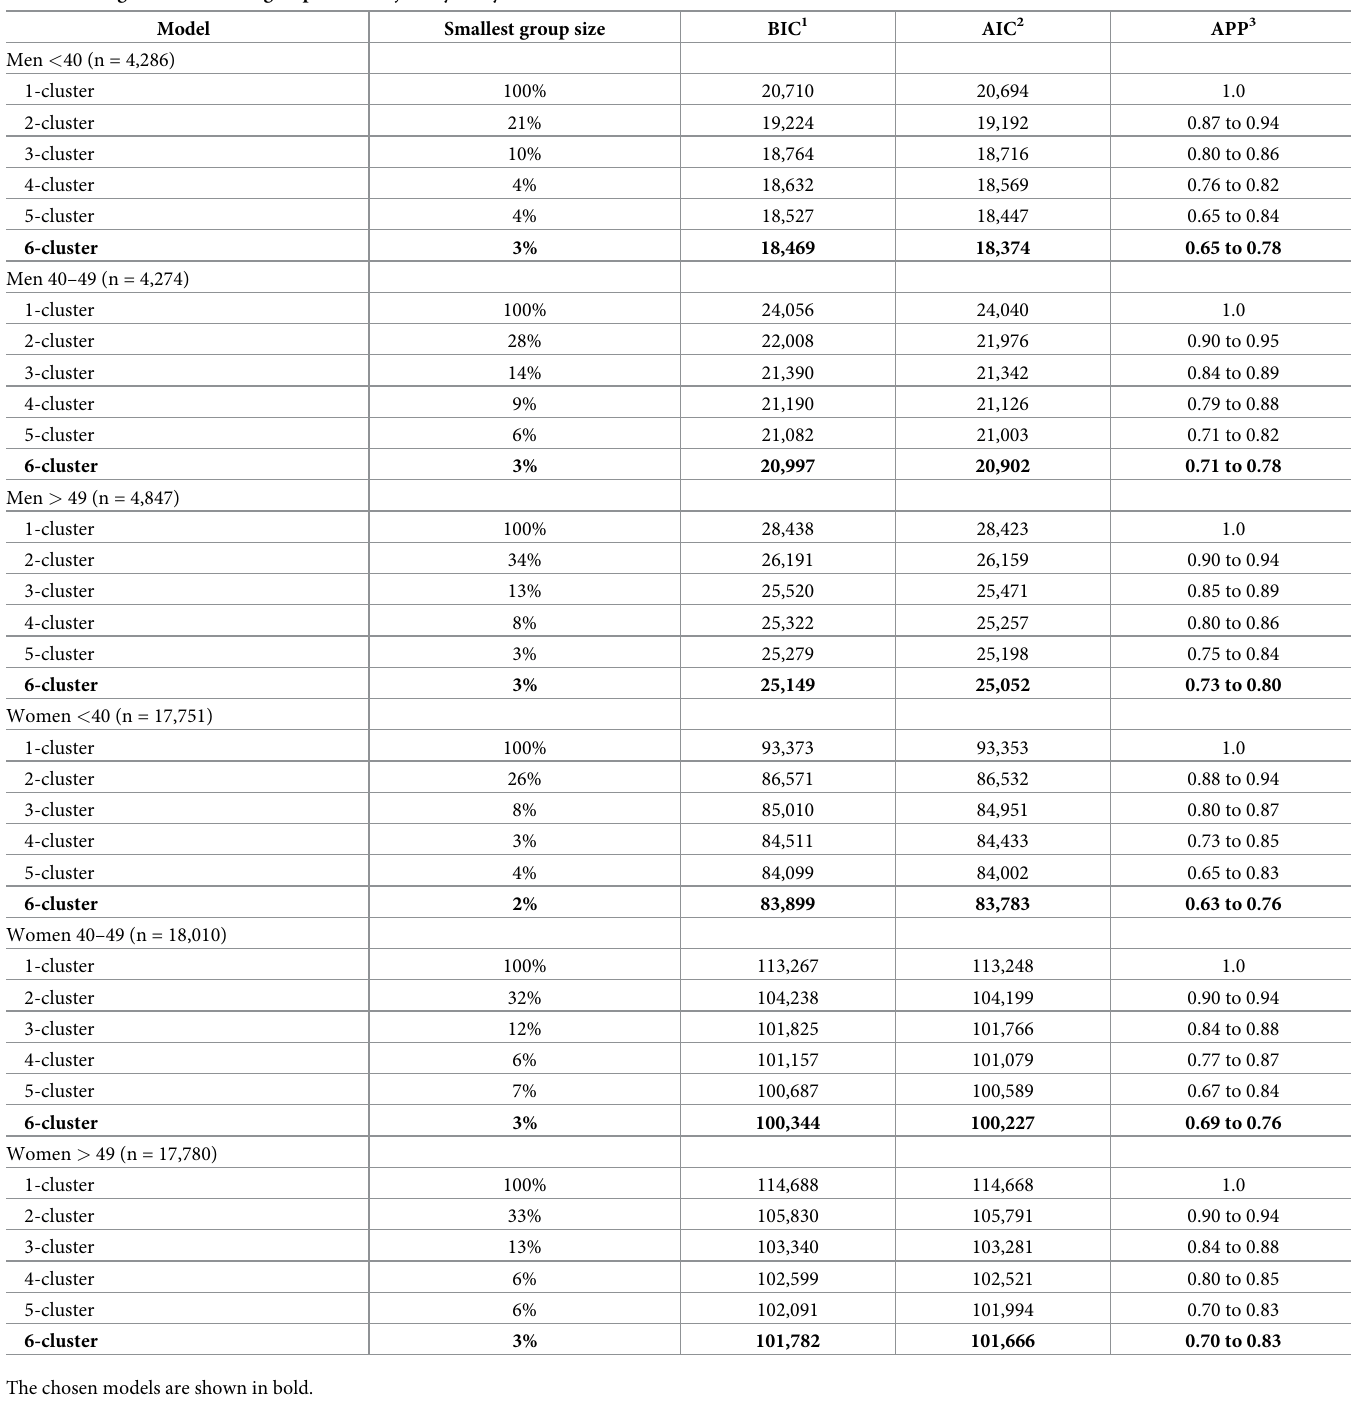
Table 1. The goodness of fit of group-based trajectory analysis